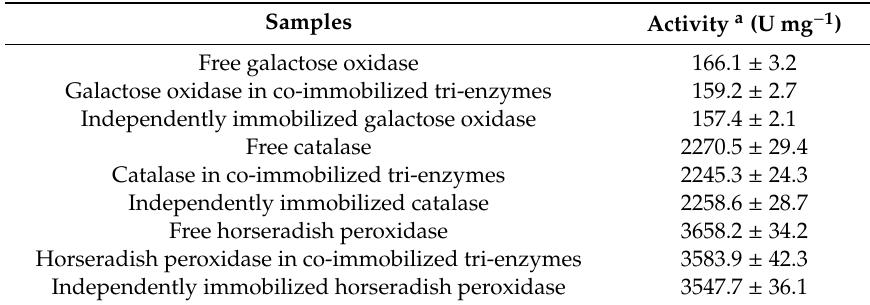
Table 2. Comparison of activity of free enzymes, co-immobilized enzymes, and independently immobilized enzymes.